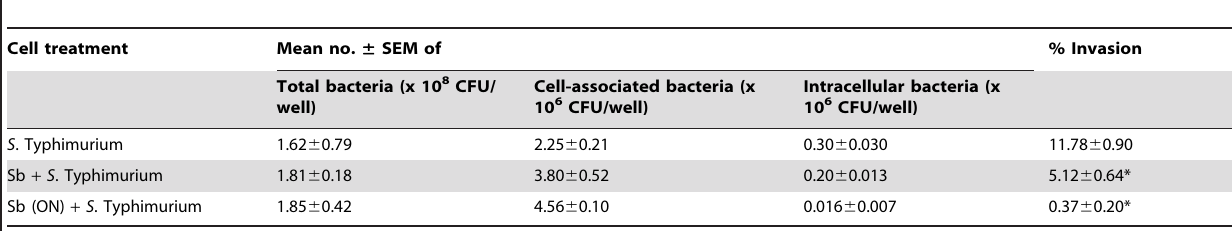
Table 1. Effect of S. boulardii (Sb) on adhesion and invasion of S . Typhimurium in T84 cells.